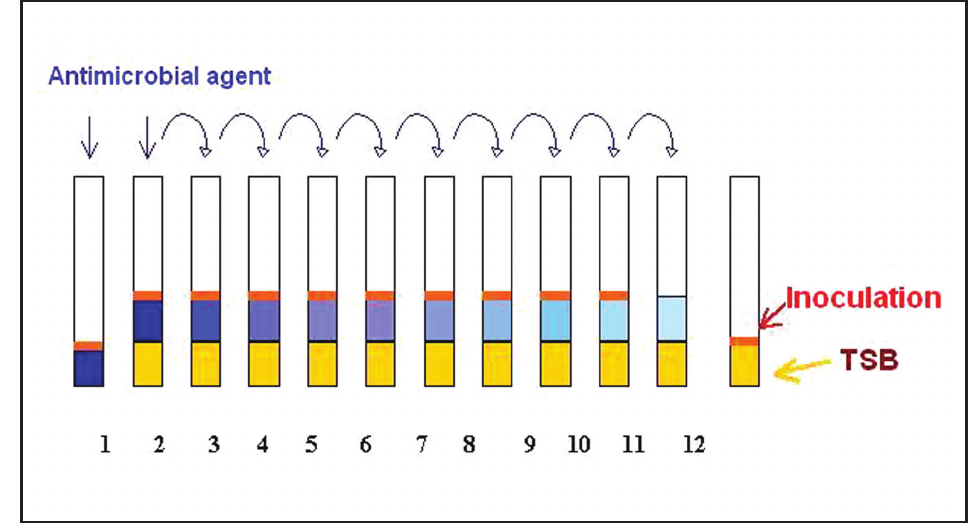
FIGURE 1 – Illustrative scheme of successive dilutions